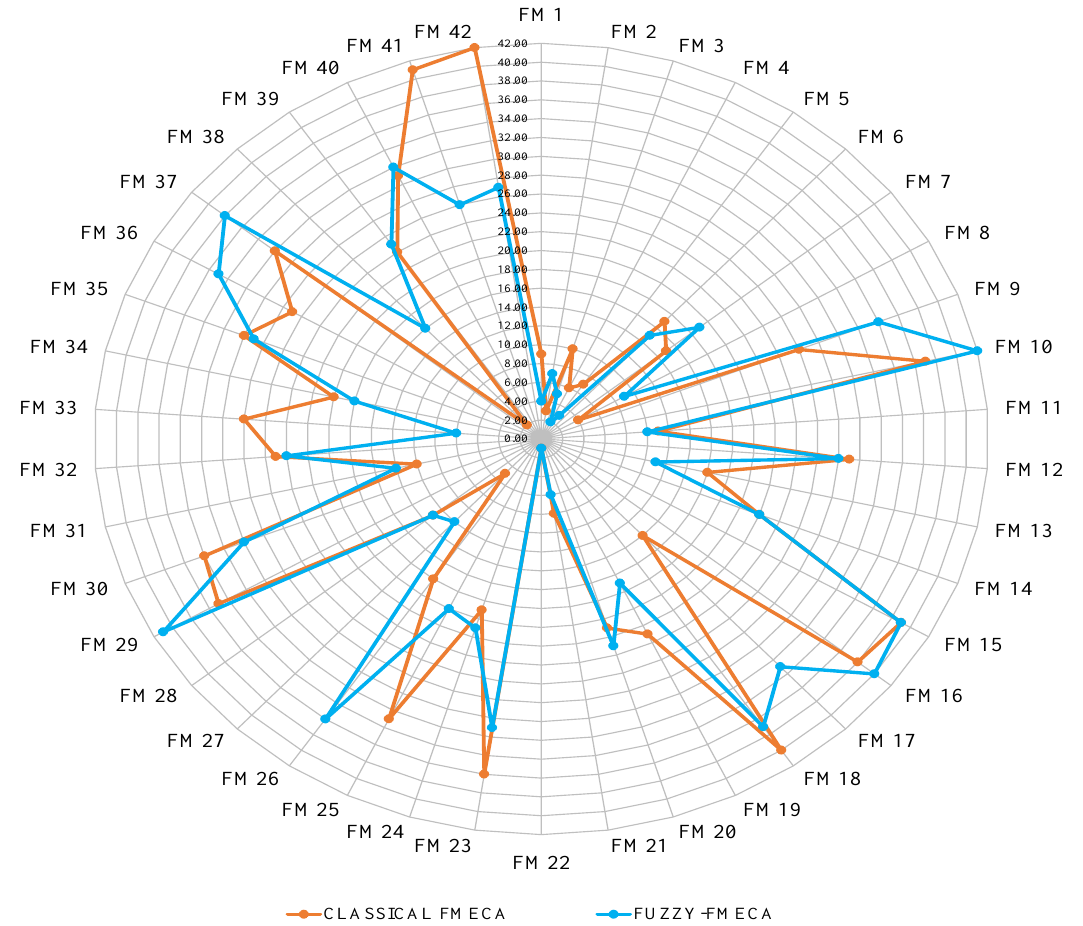
Figure 8. Radar chart showing the ranking for the classical FMECA ranking (red line) and the ranking for the fuzzy-FMECA proposed (blue line). Table 10. Rankings and risk priority number for the classical and the fuzzy-FMECA.